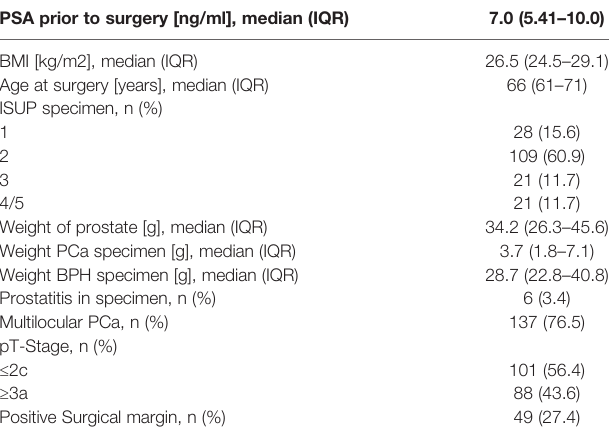
TABLE 2 | Univariable linear regression analysis correlating preoperative PSA (ng/ml) as a dependent variable with selected independent variables.